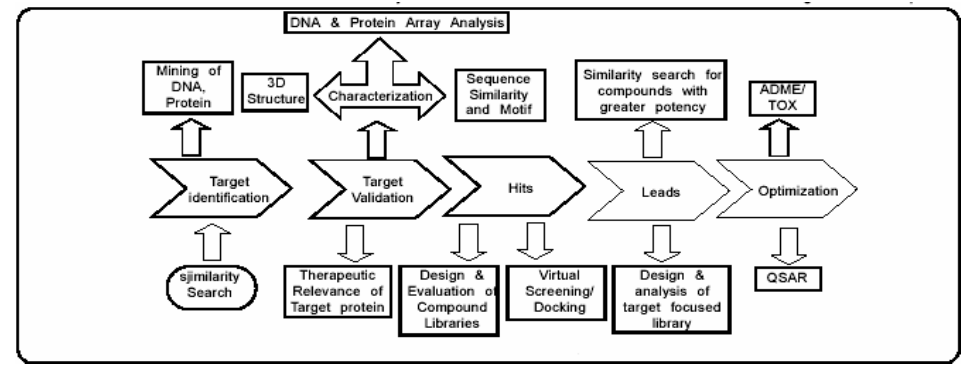
Figure 6 . Drug designing cycle. Table 1. Data